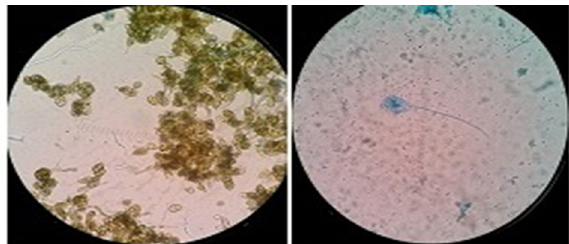
Fig. 2. Penicillium (right) and Alternaria (left) seen in the following in samples taken from different wards of